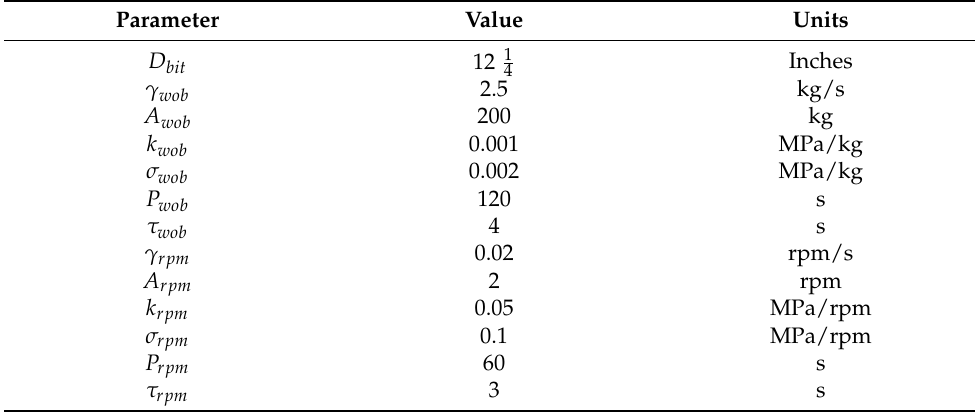
Table 3. Parameter values that are common for all the